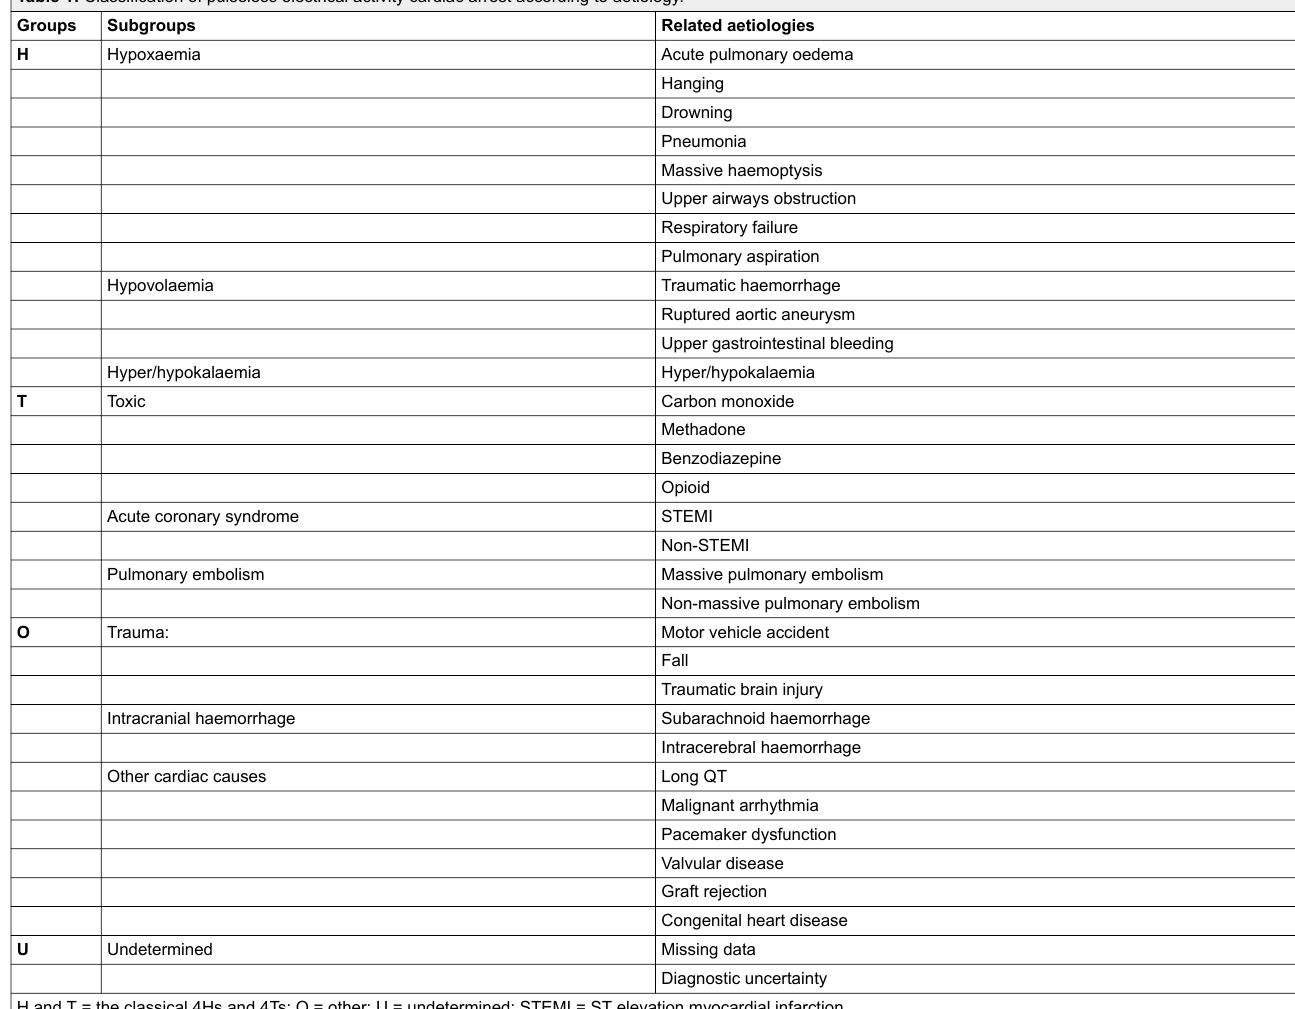
Table 1: Classification of pulseless electrical activity cardiac arrest according to aetiology.